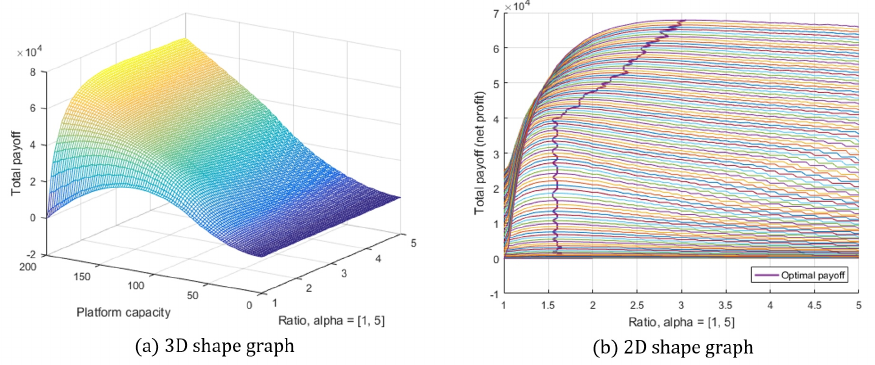
Figure 1. Visualizations of two-sided platform